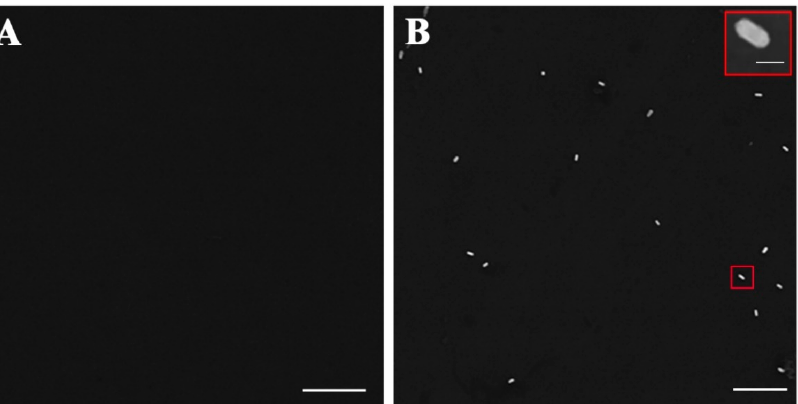
Figure 6. SEM characterization of antibody-modified chips for the capture of PEDV. ( A ) SEM image of antibody-modified chip incubated with GNR probes without PEDV. ( B ) SEM image of the captured PEDV labeling with GNR probes. The upper right corner of the image shows the enlargement of the selected area. Scale bar: 1 μ m ( A , B ) and 100 nm (the upper right corner in ( B )).